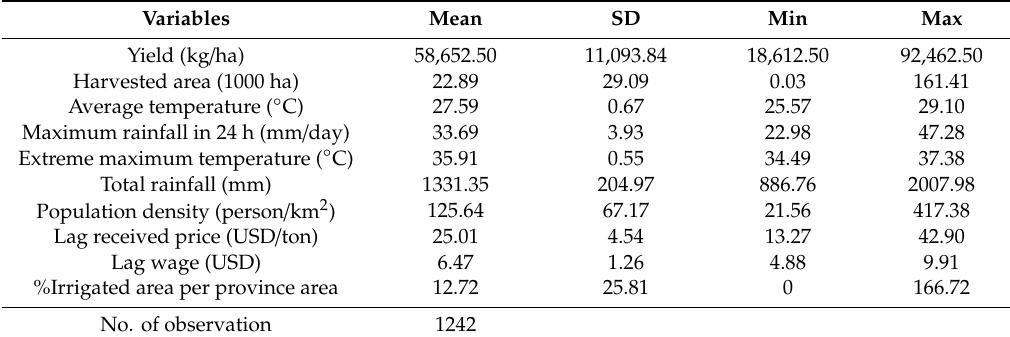
Table 1. Summary statistics of selected variables at the provincial